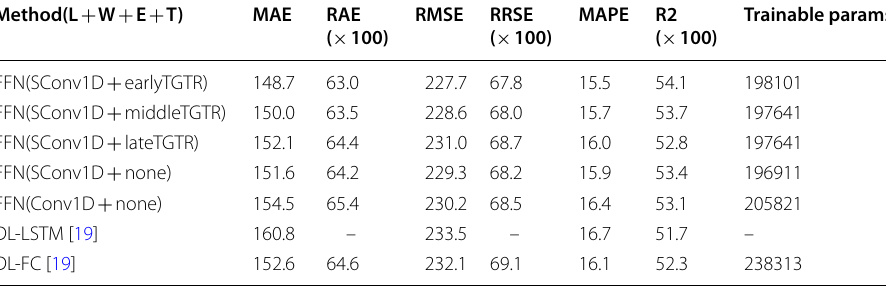
Table 4 Comparison of the performance of different methods on the test data set Method(L W E T) MAE RAE + + +